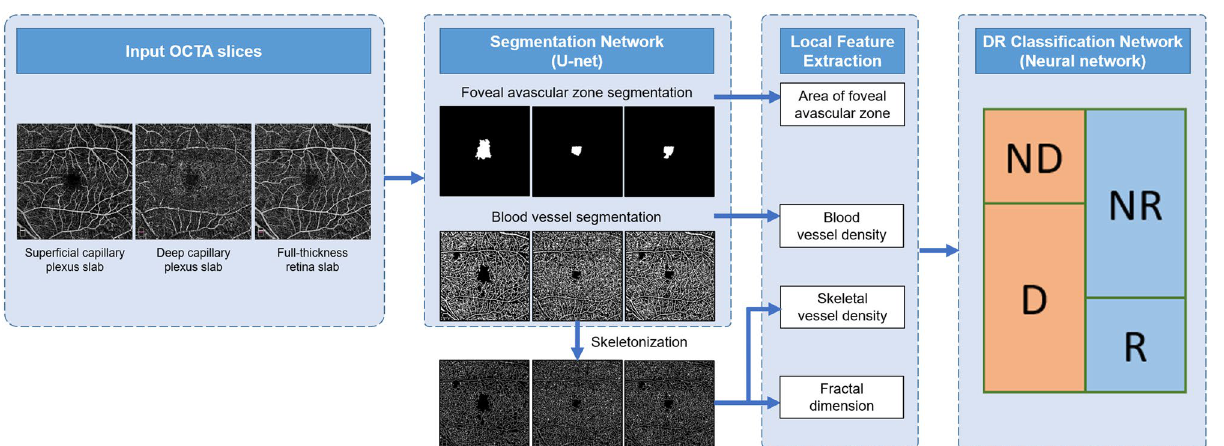
Figure 4. Machine learning-based classification networks for DR. Blood vessels and the FAZ were segmented from OCTA images using a U-net model. The segmented FAZ and vessels were processed to extract four significant retinal features, i.e., FAZ area, blood vessel density, skeletal vessel density, and fractal dimension. These features are supplied to a neural network classifier to detect the onset (D) and referable status (R) of DR. This figure was created using Office Power Point software 2019 (https:// www. micro soft. com/ ko- kr/ micro soft- 365/ power extracted high-level features. In the expanding path, intermediate feature maps of the contracting path were concatenated with the feature maps of the previous expanding path and used as input in the next expanding path. The parameters in the network were optimized using the Adam optimizer 47 with a dice similarity coefficient loss and learning rate of 0.0001. In the feature-extraction stage, four local features (blood vessel density, skeletal vessel density, fractal dimension, and size of the FAZ) were extracted from the segmented OCTA images. Finally, in the classification step, data from these four extracted features were fed into a neural network classifier to classify the OCTA images into DR and normal cases as well as referable DR and non-referable states.